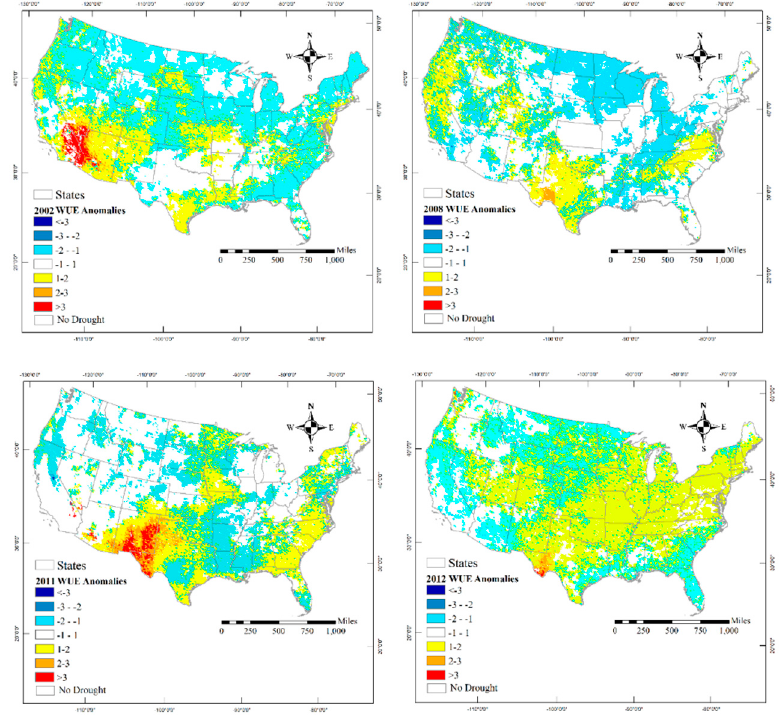
Figure 5. Spatial distribution of WUE anomalies during 2002, 2008, 2011 and 2012 drought episodes.